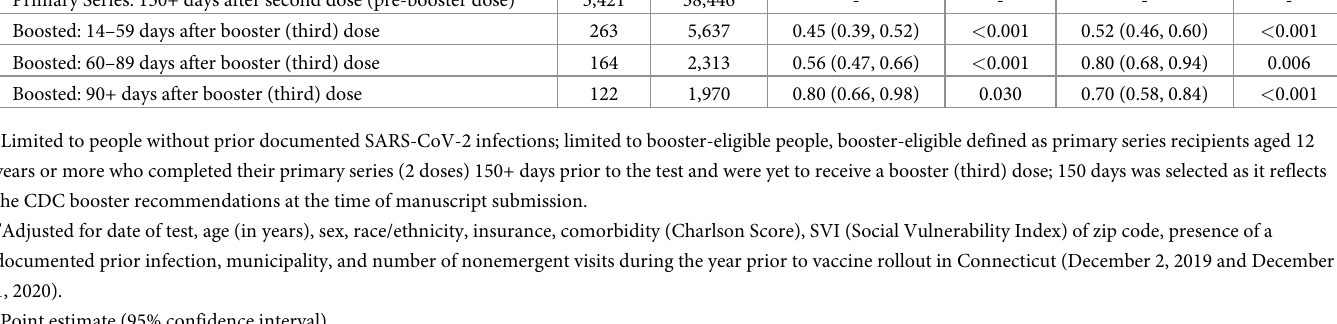
(Fig H in S1 Text). Adjusting for time between testing and completion of primary vaccination did not significantly alter the estimated association between booster doses and Omicron (line- age BA.1) infections among people with a documented prior infection (OR: 0.75, 95% CI: 0.50